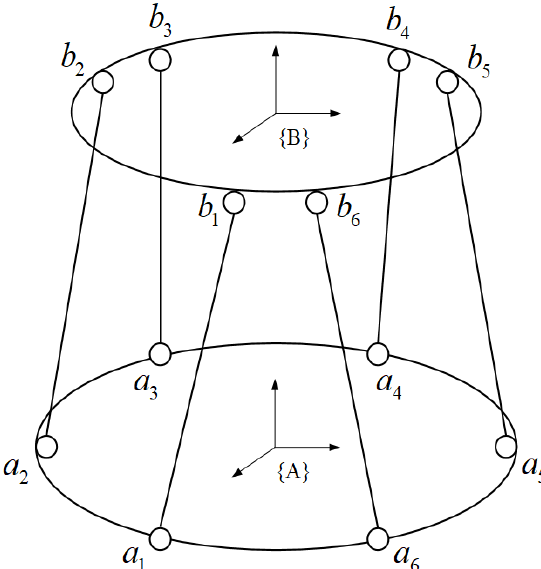
Figure 2. Diagram of the parallel Self-Stabilized system.